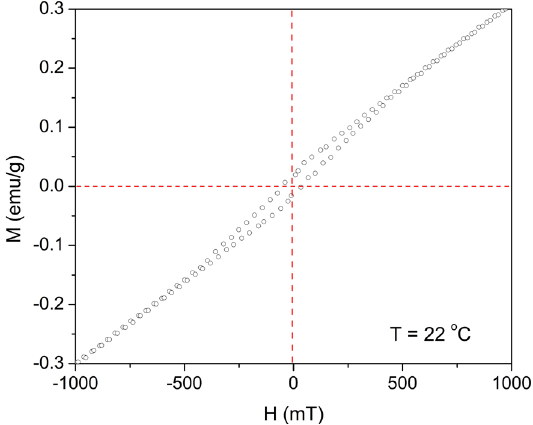
Figure 8. Magnetisation curve of CoNHH at 22